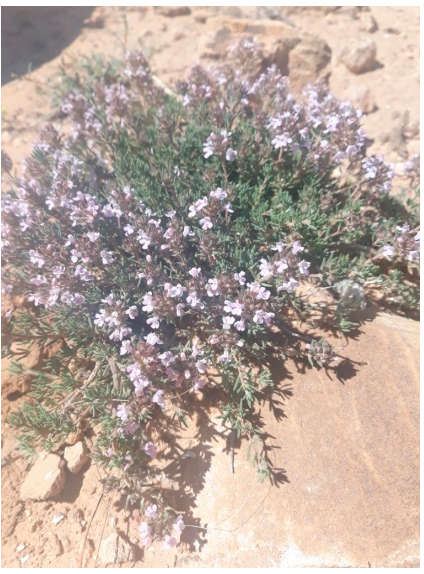
Figure 4. Thymus algeriensis Boiss. at flowering stage.